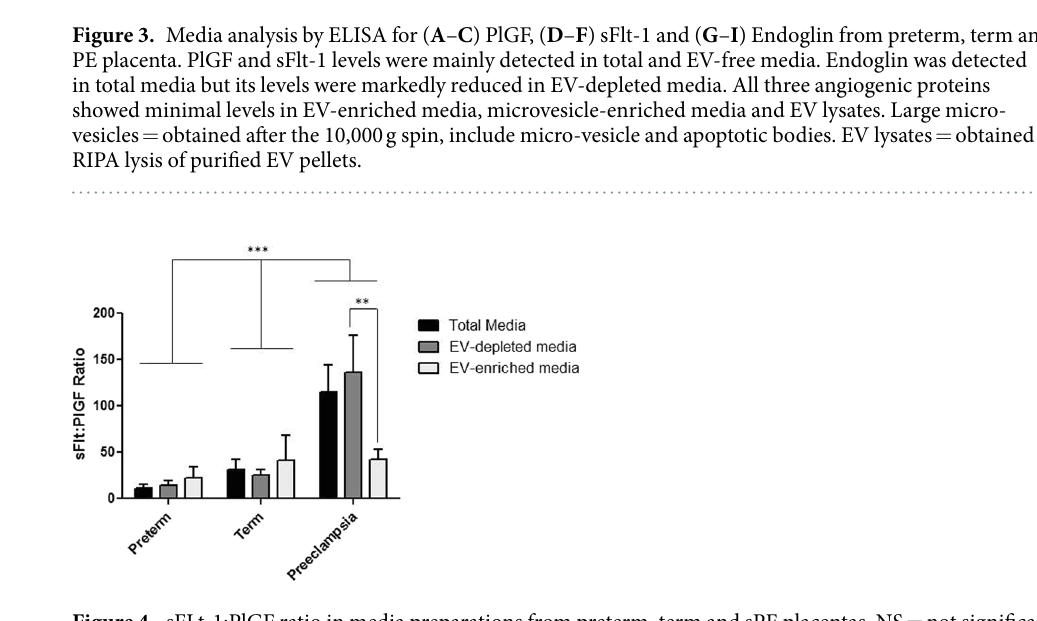
Figure 4. sFLt-1:PlGF ratio in media preparations from preterm, term and sPE placentas. NS = not